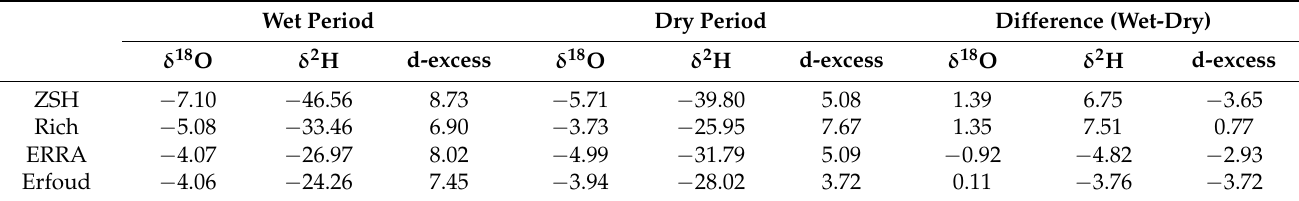
Table 5. Mean values weighted with respect to the amount of precipitation of the wet and dry